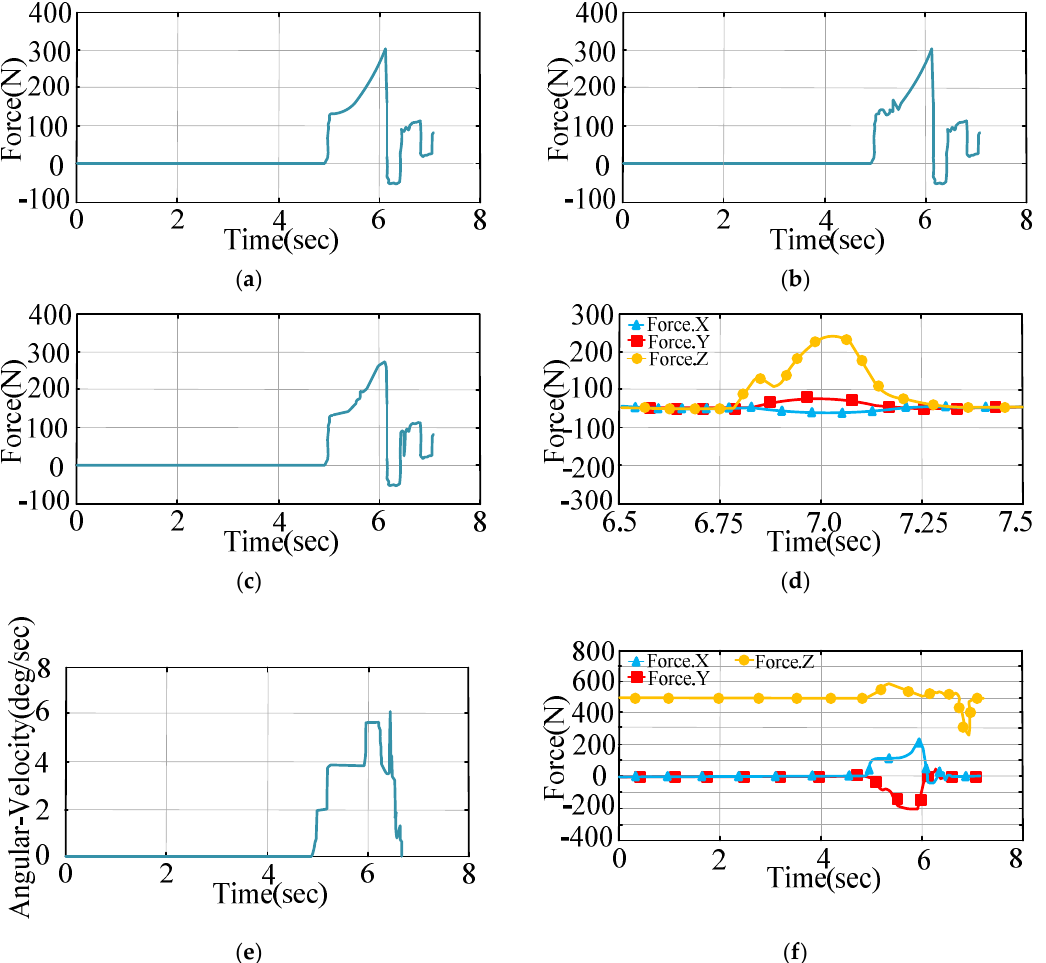
Figure 8. Curves of corresponding quantities under the frontal impact ( d ) for locking jaw 1 ( a ) for locking jaw 2 ( b ) for locking jaw 3 ( c ) between the passive docking mechanism and the matching surface ( e ) showing the angular velocity of the spherical joint ( f ) spherical joint.